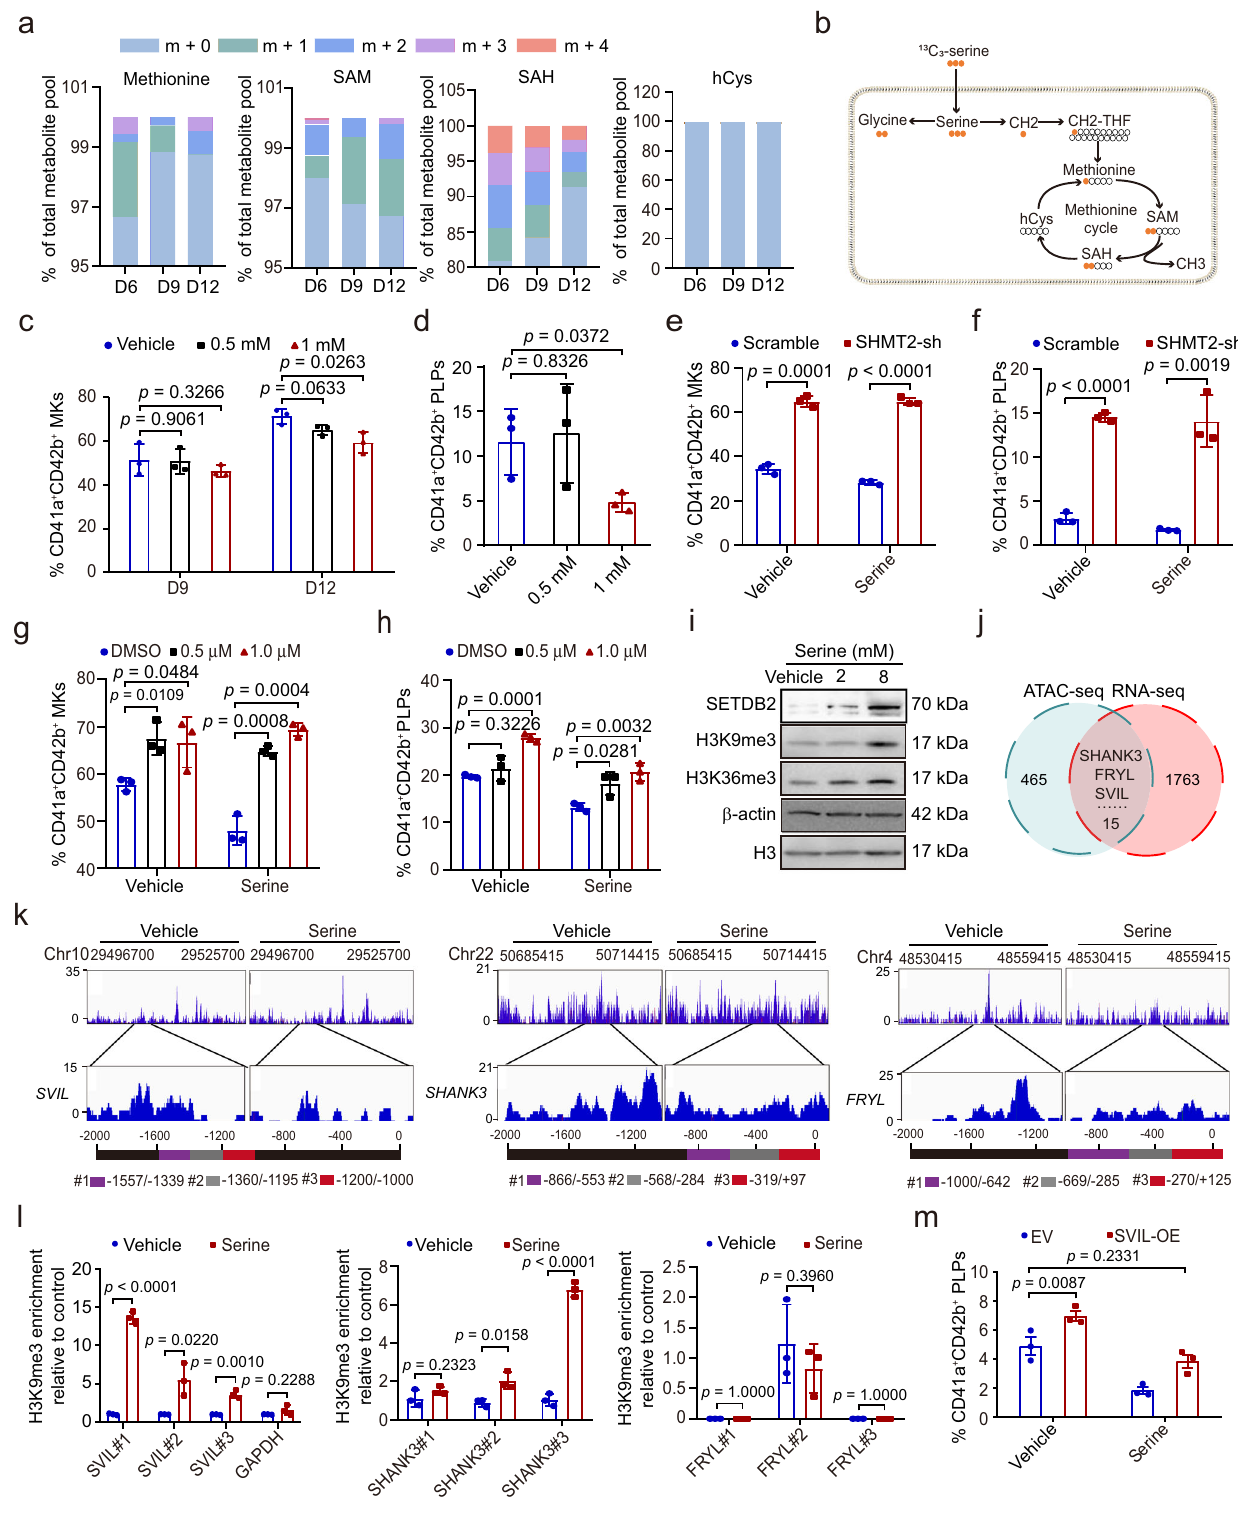
functional level, depletion of SVIL and SHANK3 inhibited mega- karyopoiesis and thrombopoiesis (Supplementary Fig. 4g – i), while overexpression of SVIL rescued the inhibitory effect of serine- mediated thrombocytopenia (Fig. 5m). To further assess whether the protein level of SVIL was also downregulated by serine, we performed Western blotting in differentiated cells treated with vehicle or serine.